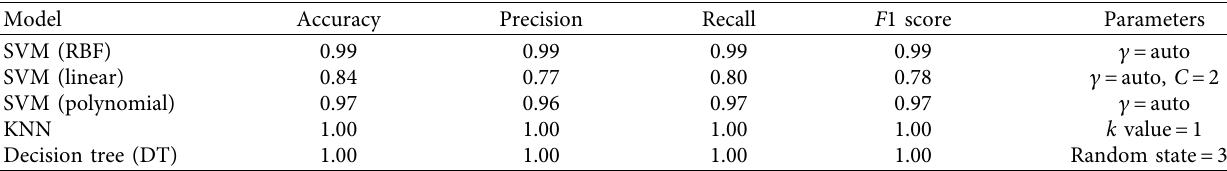
Table 14: Agreeableness classifcation report.